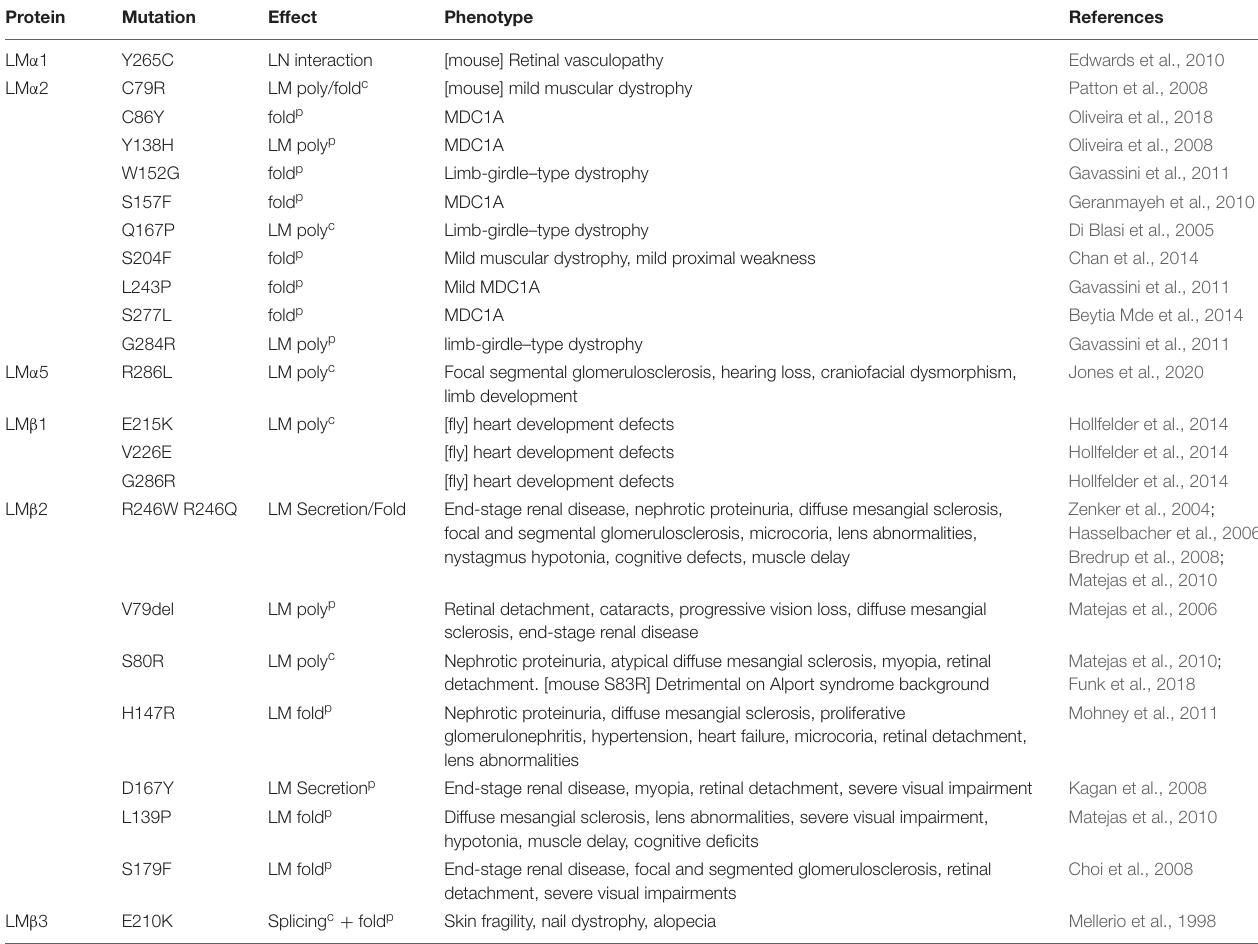
TABLE 1 | Pathogenic LN domain mutations. Protein